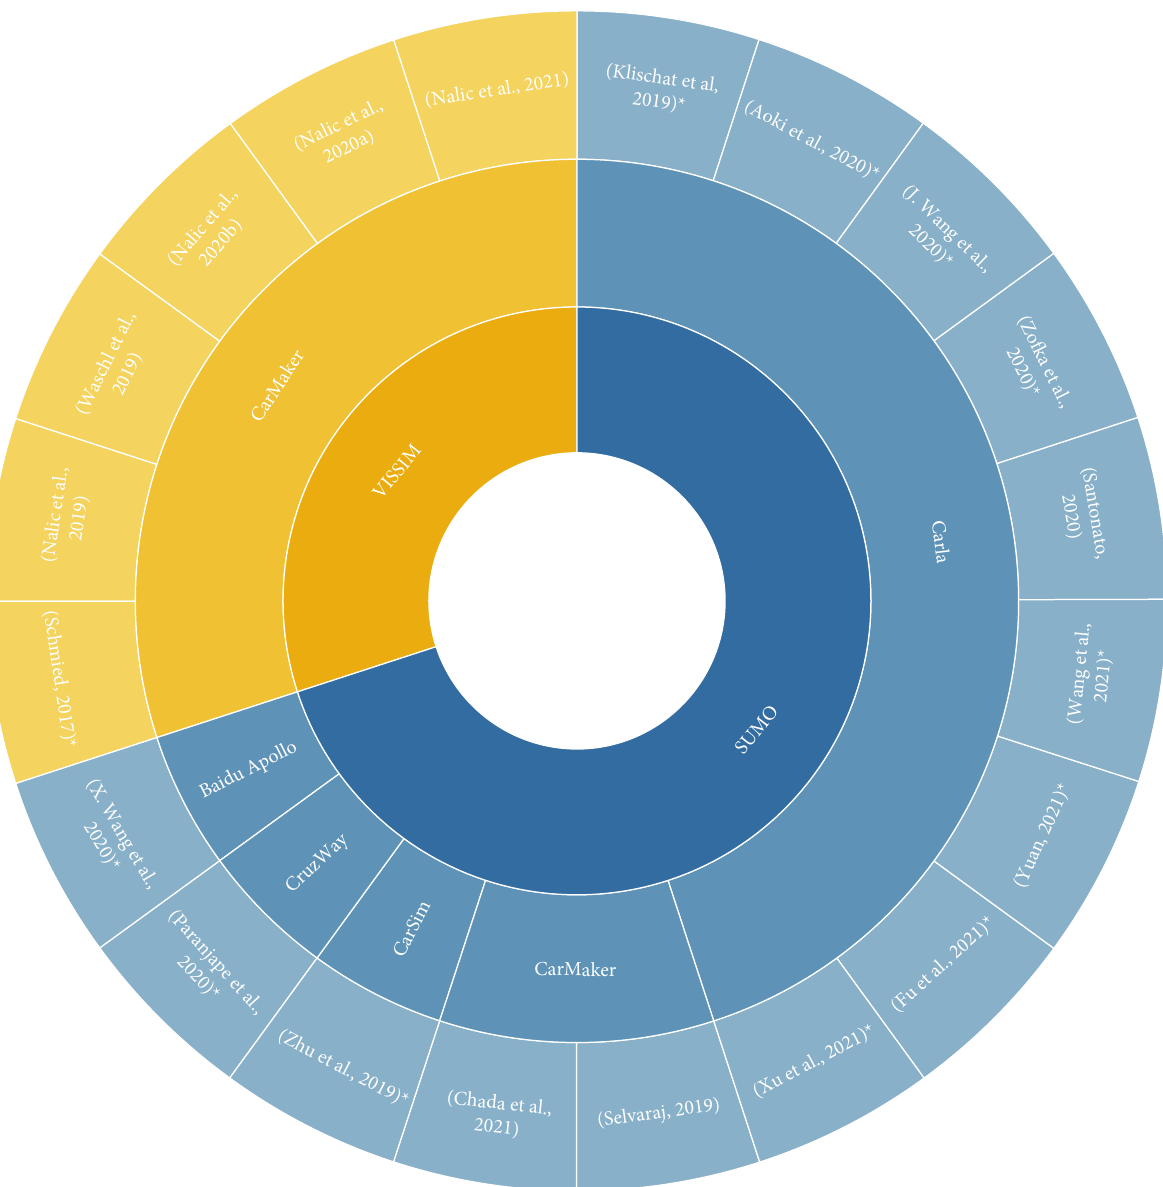
Figure 8: AV cosimulation studies over different